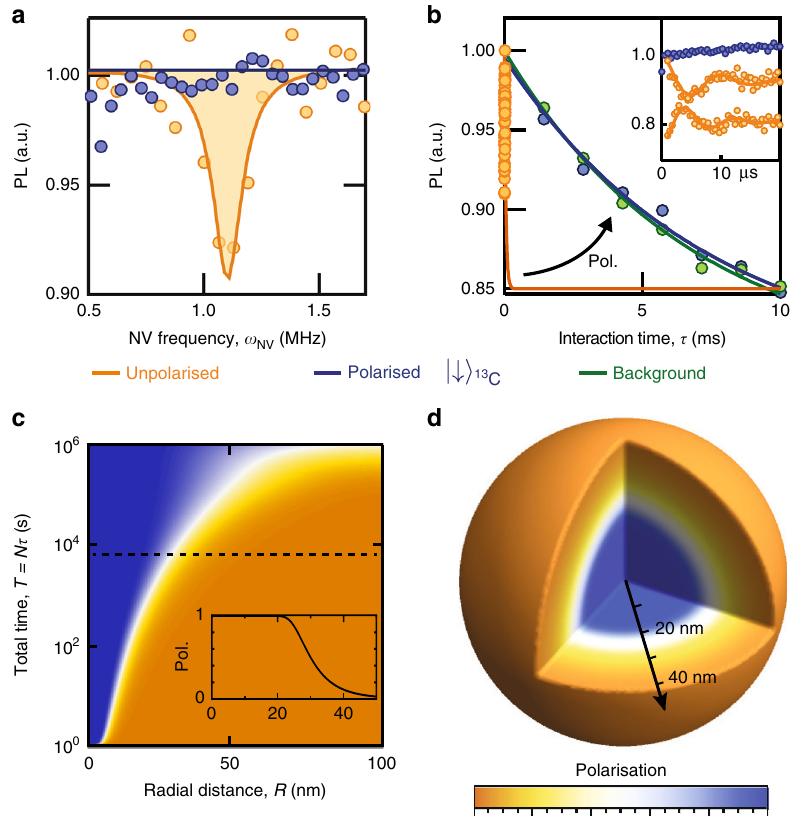
Fig. 2 Cross-relaxation induced polarisation of 13 C spins in diamond. a Cross-relaxation spectra of a single NV spin near the 13 C resonance ( ω N V ¼ 1 : 1 MHz), obtained with an interaction time τ = 4 µ s using the CRIP sequence (blue) and the depolarisation sequence (orange, only the readout following the NV initialisation in j 0 i is shown). Sequences were repeated N = 10 5 times at each point. b Cross-relaxation curves obtained by increasing τ at the 13 C resonance with the CRIP sequence (blue) and depolarisation sequence (orange), and off-resonance to obtain the background relaxation curve (green). Zoom-in at short times for the polarised (blue) and unpolarised case (orange, top and bottom curves correspond to the NV initialised in j 0 i and j (cid:2) 1 i , respectively). c Calculated radial polarisation pro fi les relative to the NV spin (averaged over all angles), calculated from Eq. (1) for a random 1.1% 13 C spin ensemble for varying total polarisation times, T = N τ . Inset: pro fi le along dashed line, corresponding to T = 2 h. d Three-dimensional representation of the polarisation distribution at T = 2